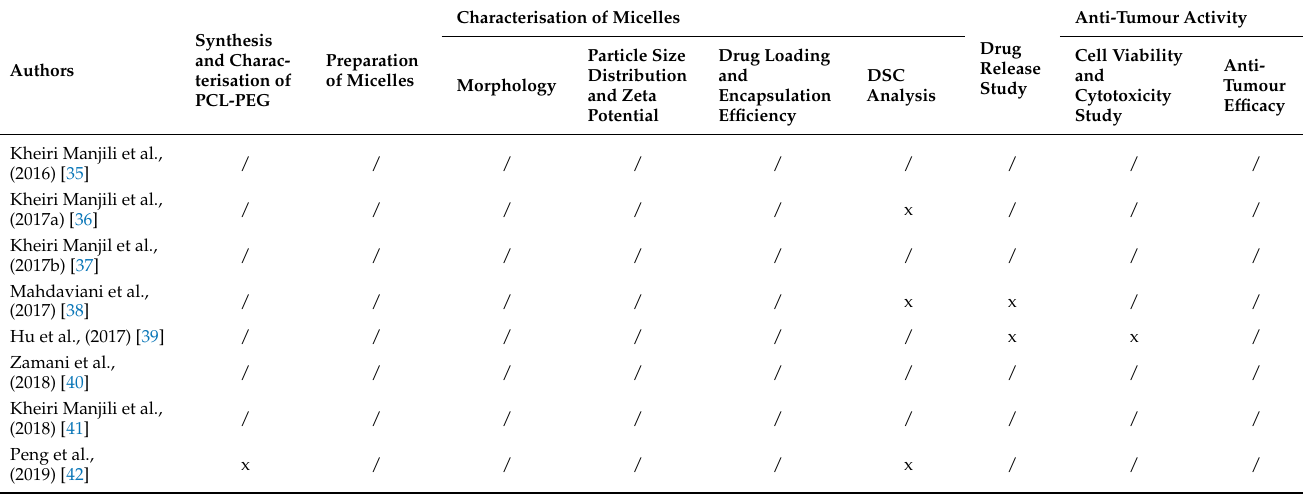
Table 3. The themes and